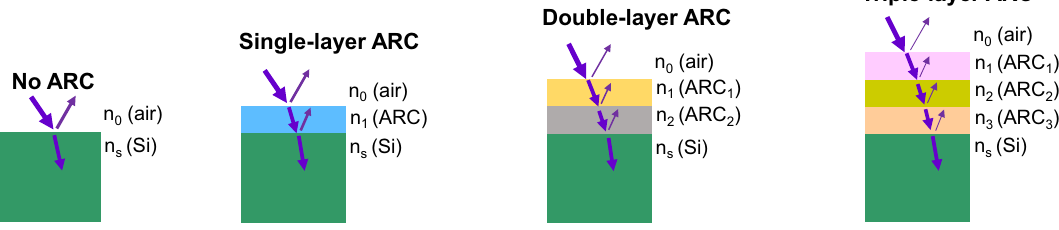
Figure 1. Schematic of various ARC features on silicon wafers, including no ARC, single-layer ARC, double- layer ARC, and triple-layer ARC. Refractive indices of different layers are indicated.